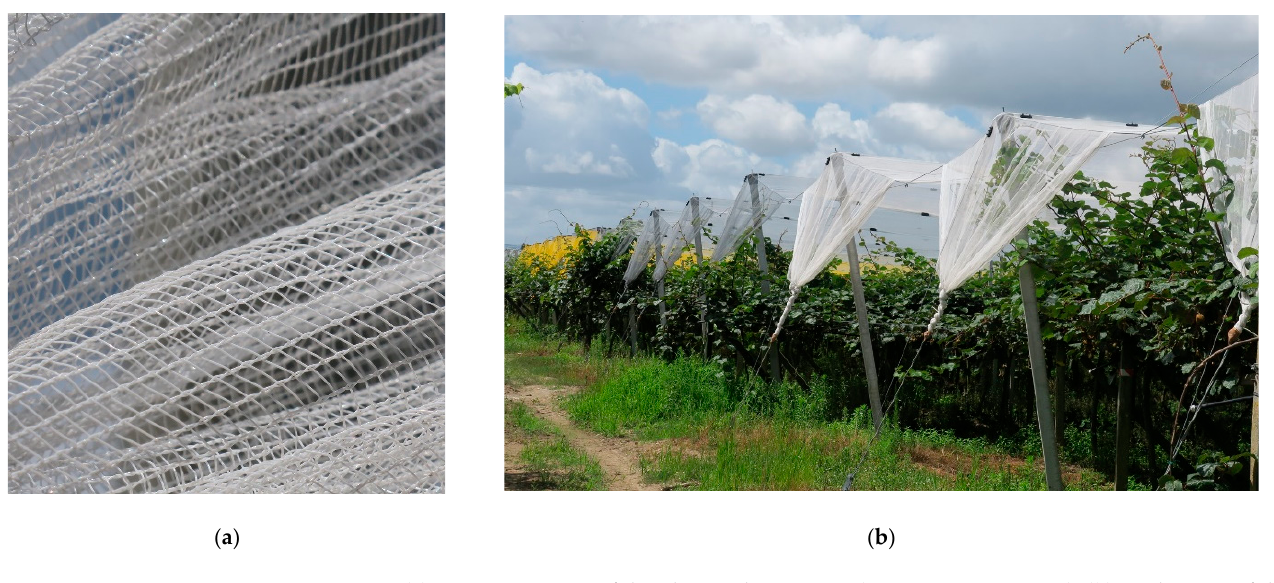
Figure 1. ( a ) Knitting pattern of the photo-selective nets (HDPE. 2.4 × 4.8 mm); ( b ) application of the pearl, grey and yellow photo-selective nets in Portugal (4°31’ N; 8°27’ W).